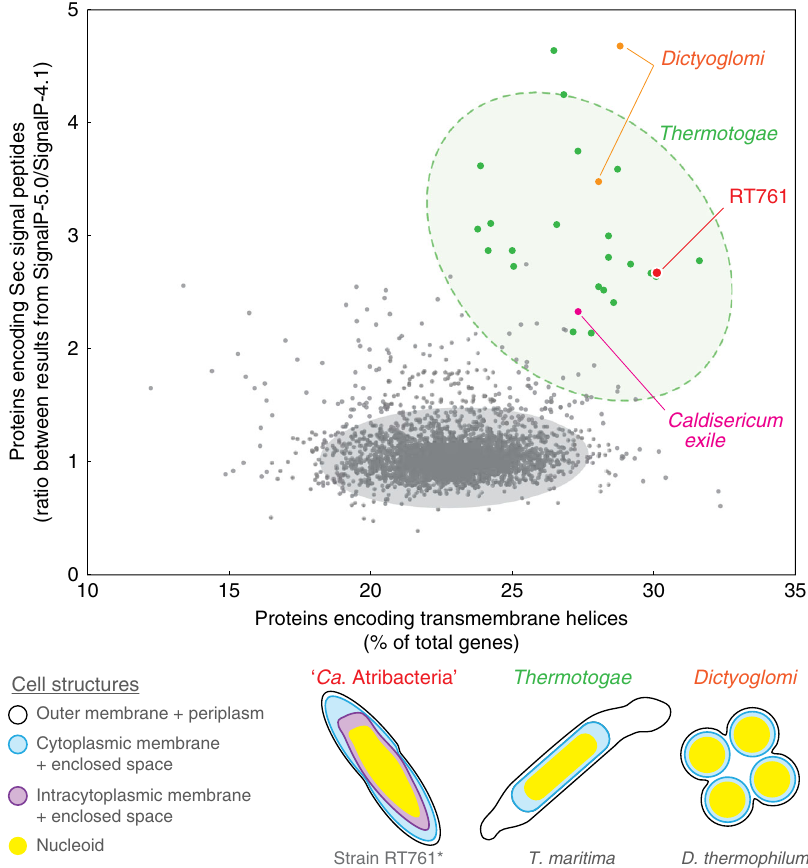
Fig. 3 Unique genomic compositions of membrane-related features observed for phyla with unique cell structures. The horizontal axis shows the genomic proportion proteins encoding transmembrane helices. The vertical axis shows the ratio of proportions of proteins encoding Sec signal peptides estimated by SignalP-5.0 and SignalP-4.1. RT761 (red), type strains from Thermotogae (green), Dictyoglomi (orange), Caldiserica (pink), and other gram- negative type strains (gray) are plotted (3502 genomes downloadable from the Joint Genome Institute Integrated Microbial Genomes and Microbiomes database). For Thermotogae and other gram-negative type strains, 95% (green) and 99.9% (gray) con fi dence ellipses are shown respectively. Source data are provided as a Source Data fi le. (Bottom) Cell structures of select species are shown for “ Ca . Atribacteria ” , Thermotogae , and Dictyoglomi . The illustrations indicate the outer membrane (black), cytoplasmic membrane (blue), intracytoplasmic membrane (purple), and nucleoid (yellow). *For RT761, the shown schematic requires further investigation to conclude the identity/role of each